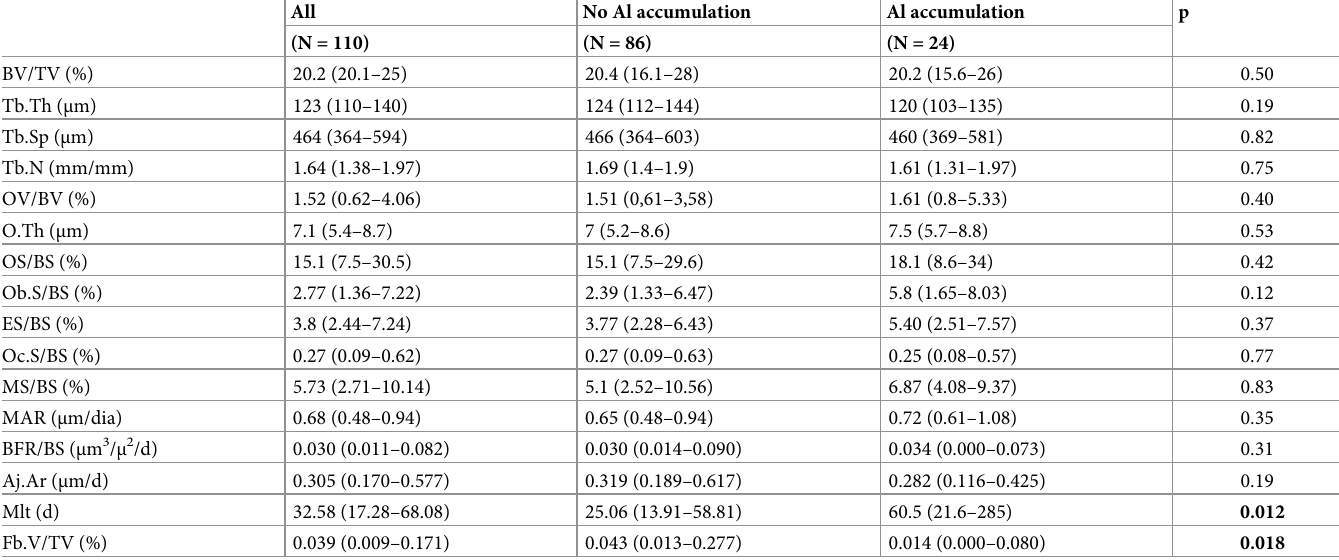
Table 2. Histomorphometric bone parameters according to the diagnosis of bone aluminum (Al)